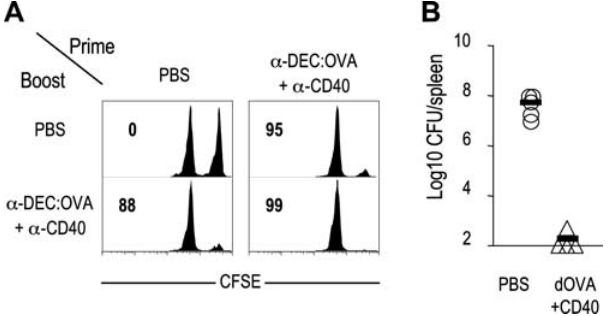
Figure 5. Memory CD8 + T cells primed with anti-CD40 show direct cytotoxicity and protective immunity. (A) In vivo CTL activity. C57BL/6 mice were primed with PBS or anti-DEC:OVA + anti- CD40, and boosted with PBS or anti-DEC:OVA + anti-CD40 at day 60. 5 d after boosting, CTL activity was determined by challenge with CFSE hi OVA257-264 peptide-loaded splenocytes. Numbers indicate % of specific killing. (B) Bacterial numbers in spleen at day 4 after infection. B6 mice were primed with PBS or anti-DEC:OVA + anti-CD40, and 60 d